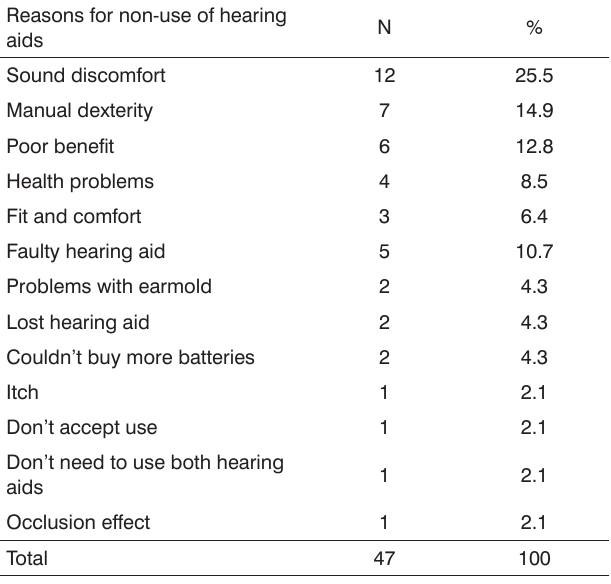
Table 2. Frequency and percentage frequency distribution of reasons for non-use of hearing aids.